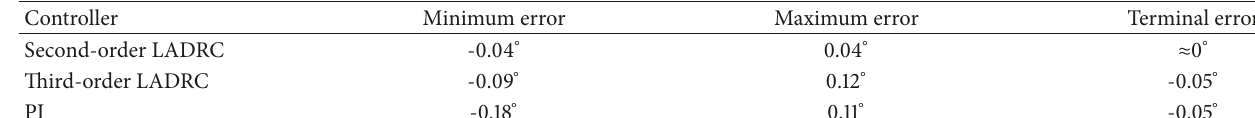
Table 3: Minimum, maximum, and terminal error of three controllers.